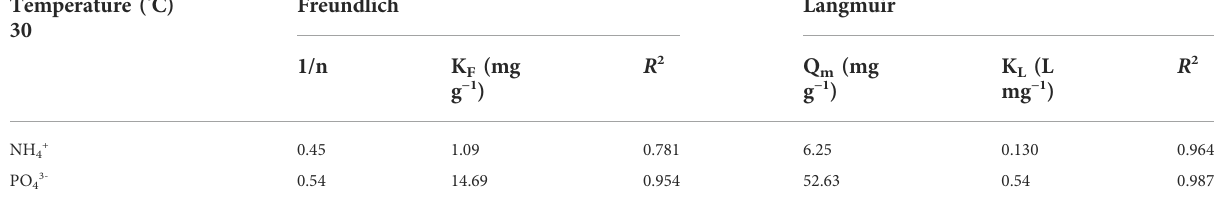
TABLE 2 Isotherm co-adsorption values of phosphate and ammonium ions on TiO 2 /zeolite nanocomposites. Temperature ( °